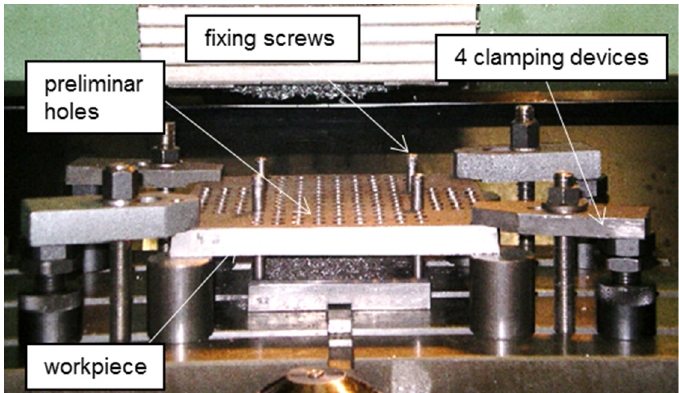
Figure 1. Mounting of the plate set-up for tapping experiments.